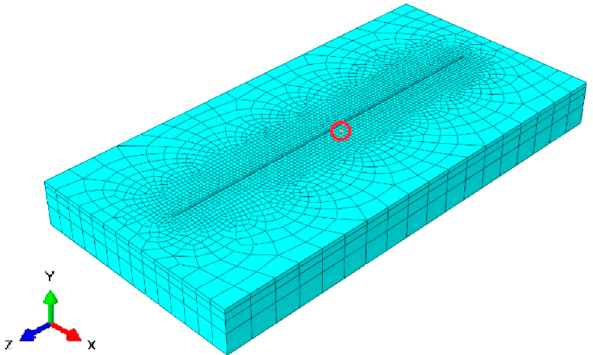
Figure 6. The meshed model with marked nodal position.